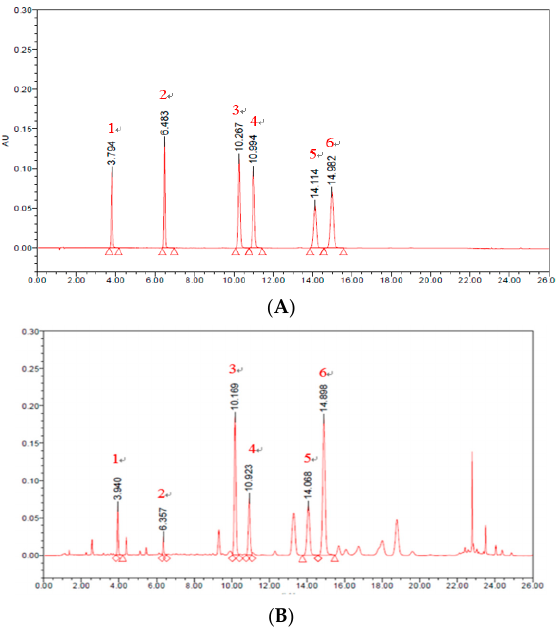
Figure 1. Ultra performance liquid chromatography (UPLC) chromatography of standard ( A ) and hot water extraction of Chrysanthemum ( Chrysanthemum morifolium Ramat) flowers (HCF) ( B ). Peak 1, chlorogenic acid; Peak 2, 1,5-Dica ff eoylquinic acid; Peak 3, luteolin-7- O -glucoside; Peak 4, luteolin- 7-O -glucuronide; Peak 5, 3,5-Dica ff eoylquinic acid; Peak 6, apigenin- 7-O